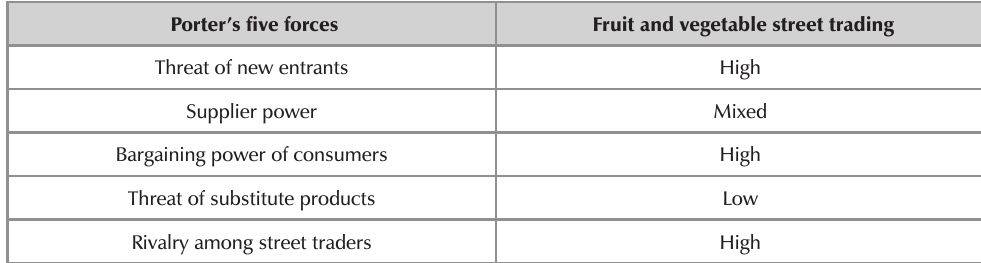
Summary of relative impact of Porter’s five forces on fruit